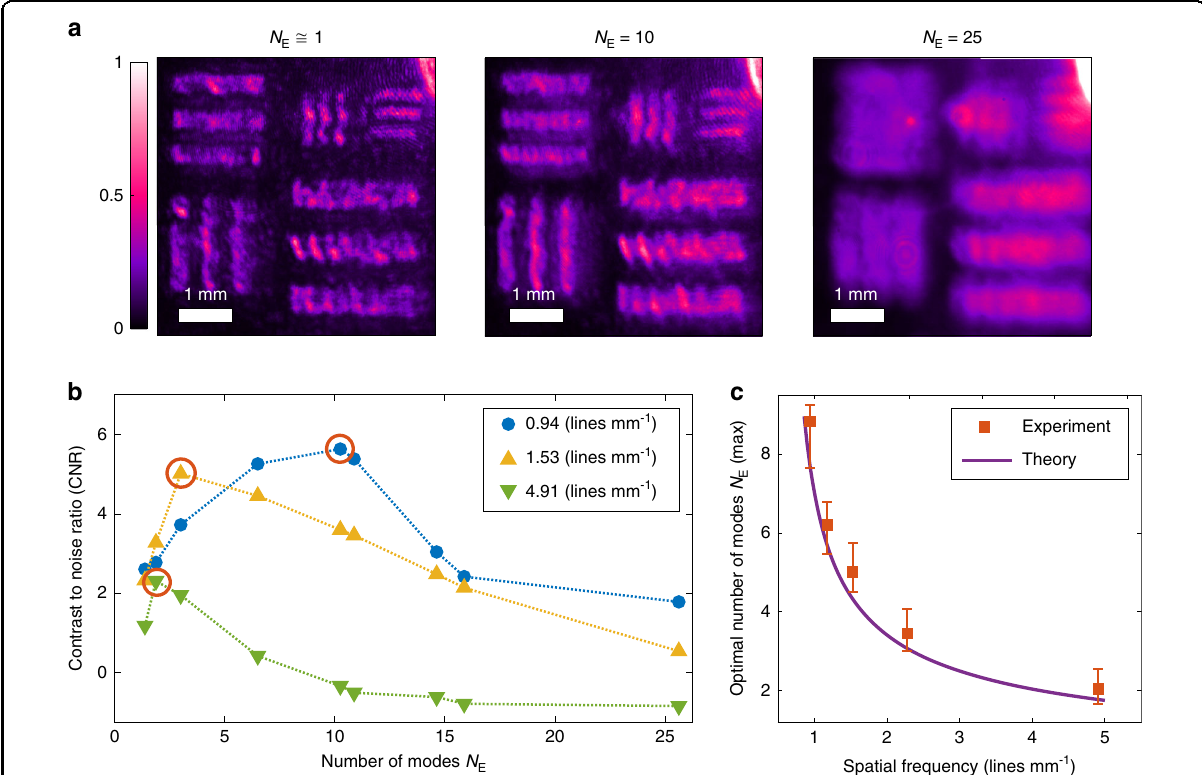
Fig. 5 Optimal degree of spatial coherence. a Three holographic images of USAF test charts obtained with the same meta-hologram and illuminated by the DCL with varying degrees of spatial coherence. As the effective numbers of spatial modes N E increases, the spatial coherence of the illumination decreases and the coherent artifacts are suppressed, however, the image resolution is impaired. b Contrast to noise ratio (CNR) versus the effective number of modes N E for three spatial frequencies in the test charts. The CNR fi rst increases with N E , reaches a maximum (circled in red) and then decreases. The maximum of the CNR shifts to a lower N E for higher spatial frequencies (smaller feature size). c The optimal number of spatial modes N ð max Þ at the maximal CNR decreases, as the spatial frequency (inverse of spatial resolution) increases. The purple curve is the E theoretical prediction of our